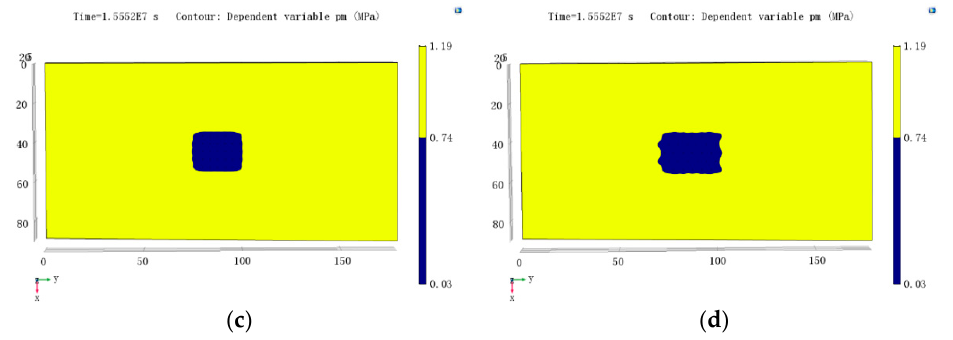
Figure 11. Outburst elimination areas before and after optimization. Outburst elimination areas on the tangent plane at X = 37 m ( a ) before and ( b ) after optimization. Outburst elimination areas on the inclined plane of the borehole bottom ( c ) before and ( d ) after optimization.